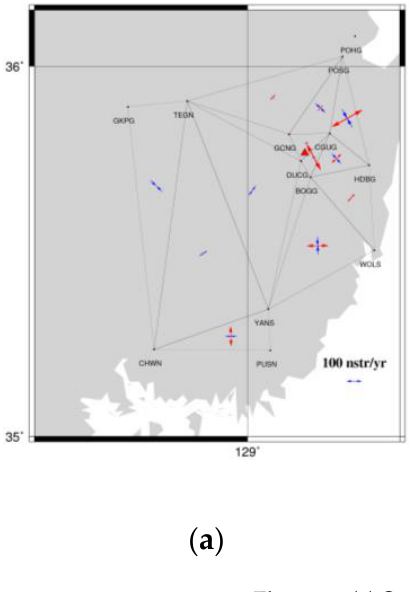
Figure 7. ( a ) Stress strain of the triangular network in 2018–2019; ( b ) stress strain of the triangular network in 2020–2021. The red triangle represents the epicenter of the earthquake that occurred on 12 September 2016.